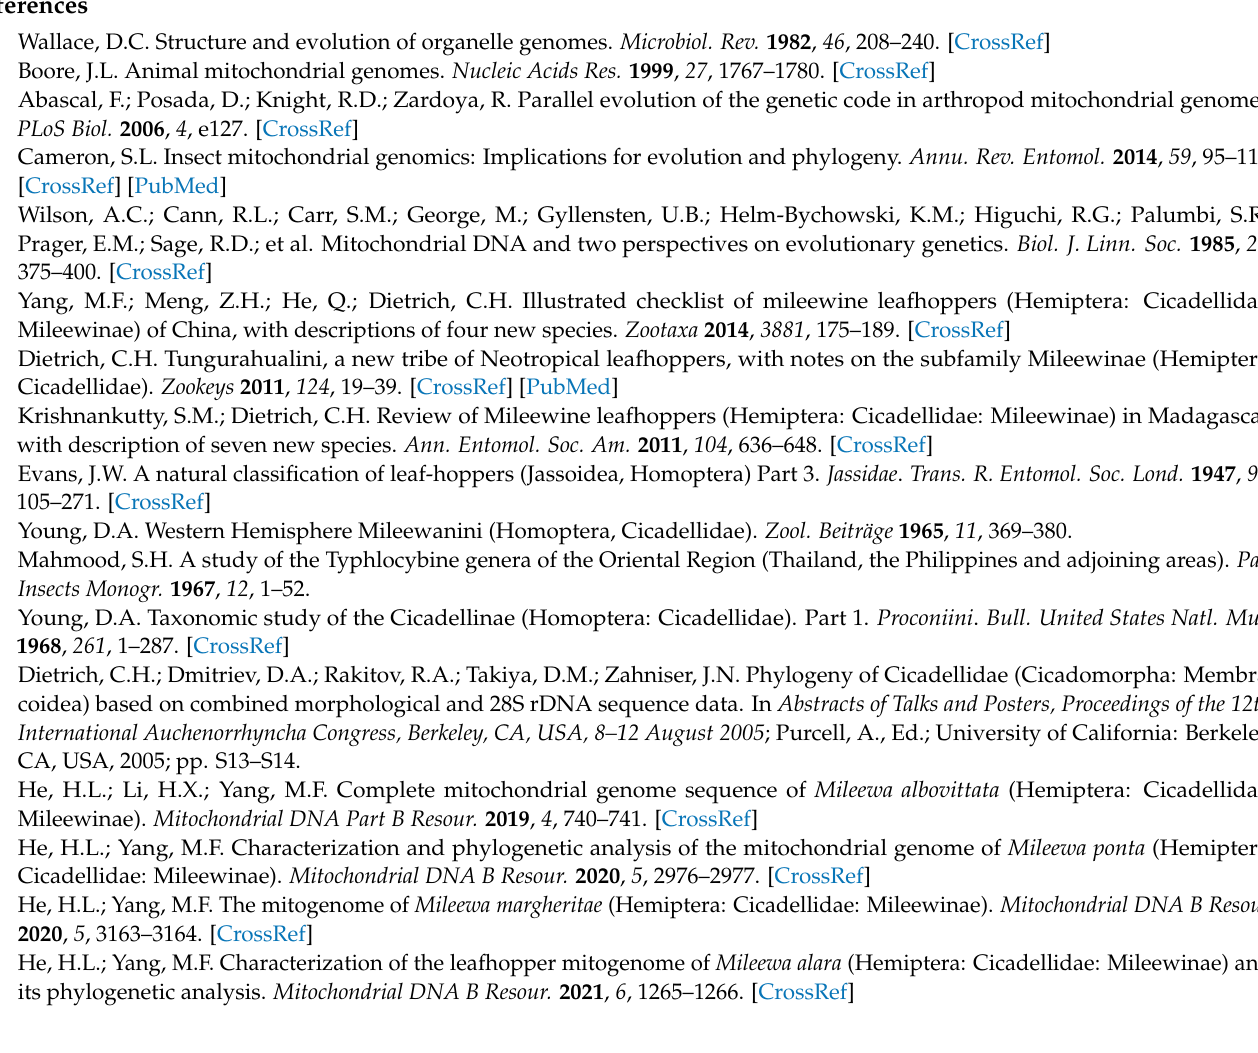
Table S2: Primers used for mitogenome analysis. Table S3. Best partitioning scheme and nucleotide substitution models for different datasets selected by PartitionFinder. Table S4: Nucleotide composi- tion and skewness comparison of Mileewinae mitogenomes. Table S5: Mitogenomic organization of Mileewa rufivena . Table S6: Mitogenomic organization of Ujna puerana